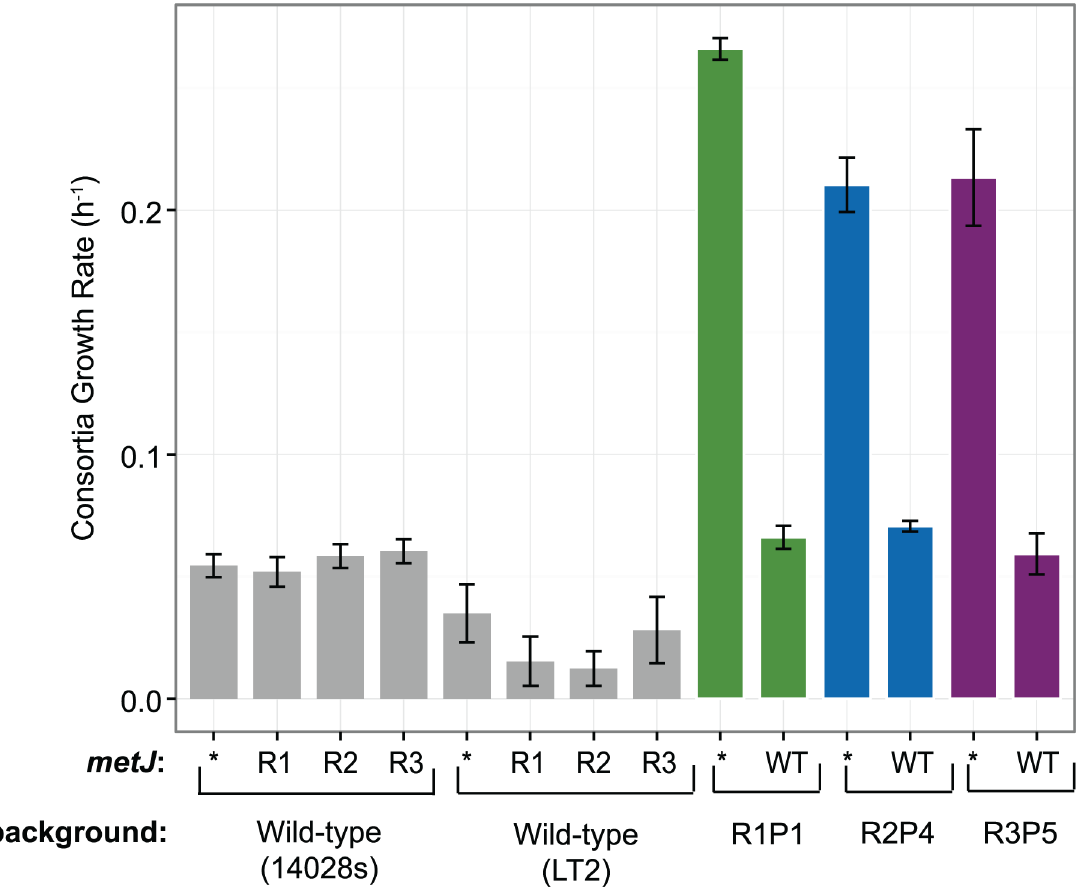
Fig 3. Ethionine resistant metJ is necessaryfor cooperative phenotype in S . enterica . Wild-type and Eth R allelesof metJ were substituted into wild-typeand evolved S . enterica backgrounds. Asterisks indicate no metJ substitution.Error bars indicate standarderror of three